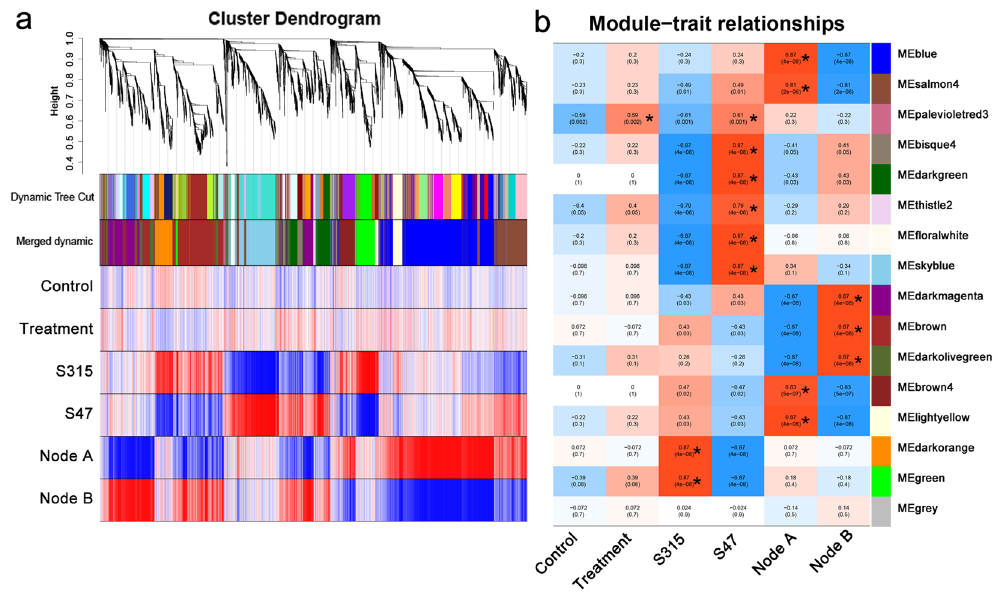
Figure 3. WGCNA module identification and correlation analysis. ( a ) the clustering dendrogram and expression heatmap of genes identifying the WGCNA modules. ( b ) the correlation of the identified modules with the Cd content in different treatments. Modules significantly associated with the traits with identified with |cor | > 0.5 and p value < 0.05, and are indicated by asterisk * . Red and blue color notes positive and negative correlation with gene expression,